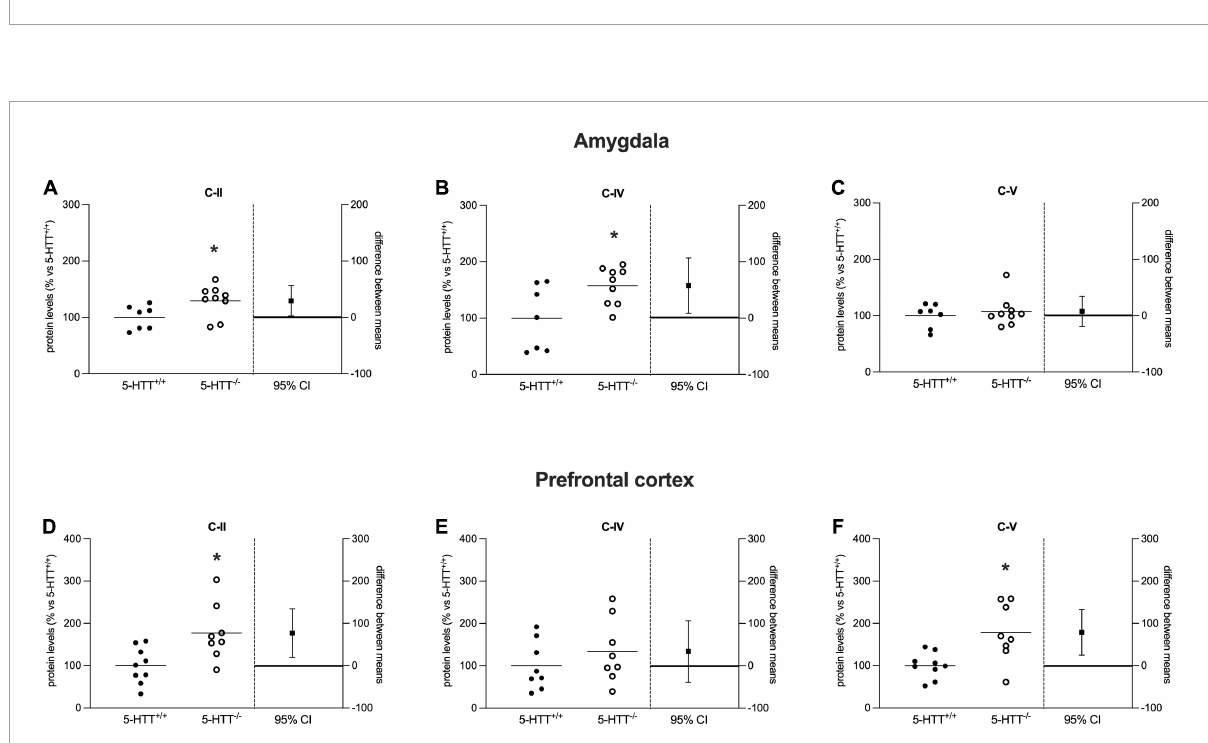
FIGURE5 Analysis of OXPHOS complexes C-II, C-IV, and C-V protein levels in the amygdala (A–C) and in the prefrontal cortex (D–F) of 5-HTT + / + and 5-HTT − / − rats. The results are represented as Gardner–Altman plots. The black square shows the difference between the two means, and the error bar shows the 95% confidence interval of that difference. The data are expressed as a percentage of 5-HTT + / + (set at 100%) of 6 to 10 independent determinations. * p < 0.05 vs. 5-HTT + / + (Unpaired t